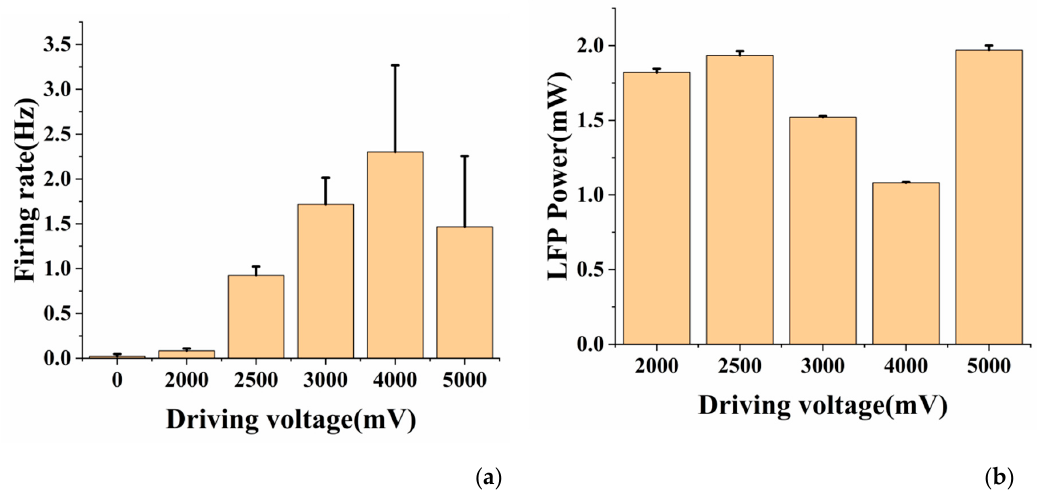
Figure 6. ( a ) The average spike firing rate of neurons under different driving voltages;( b ) The mean LFP power (0-8 Hz) of neurons under different driving voltages. Error bars indicate standard deviation of 3 channels and N = 2 (N is the number of experiments).